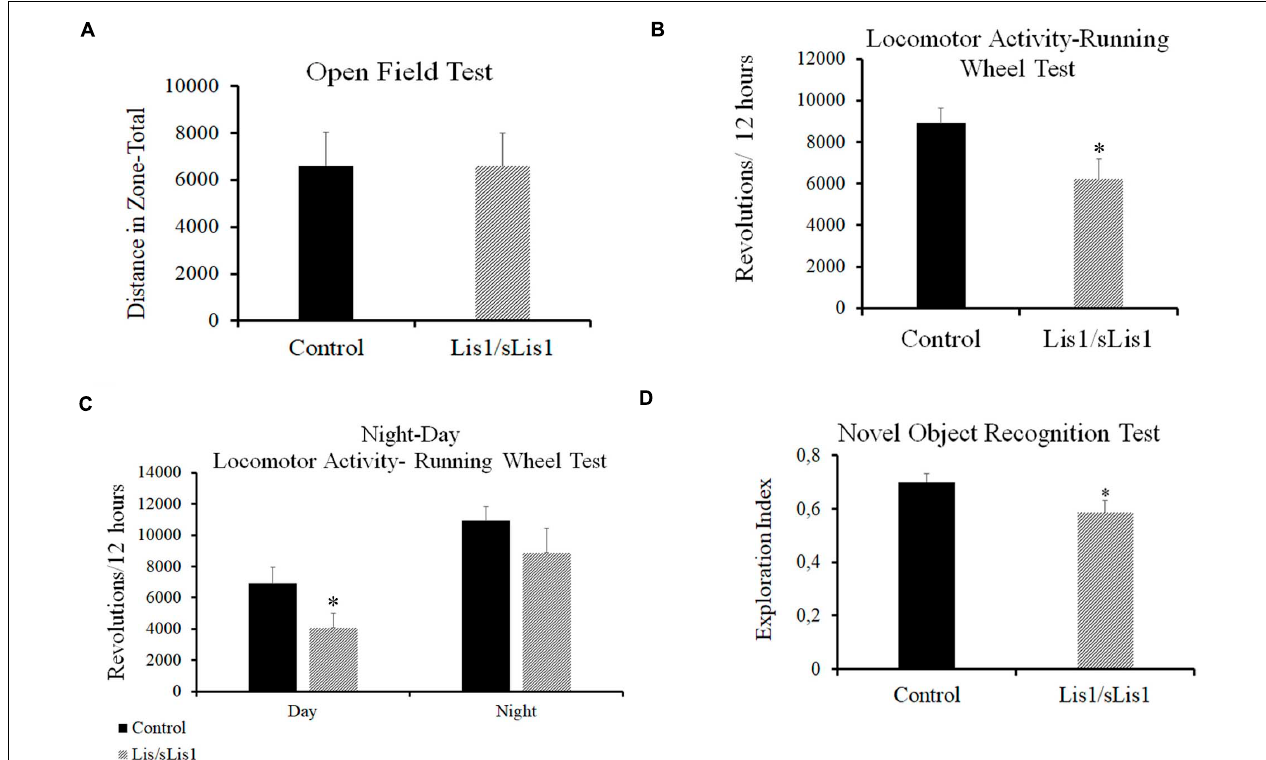
FIGURE 7 | Behavioral alterations in Lis1/sLis1 mutant mice. (A) Ambulatory locomotion was analyzed using an Open Field Test, but no behavioral differences were observed in Lis1/sLis1 mutant mice compared to controls. (B) Spontaneous locomotor activity was analyzed through a Running Wheel Analysis. The histogram shows a reduction in the total activity averaged over 12 h in Lis1/sLis1 mutant mice. (C) Night-Day locomotor activity analysis showing a statistically significant trend toward less activity during the day. No differences were detected during the nighttime period. (D) The Novel Object Recognition Test was used to study memory impairment in Lis1/sLis1 mutant mice. The histogram shows a lower exploration index when the mice were exposed to a new object together with a familiar